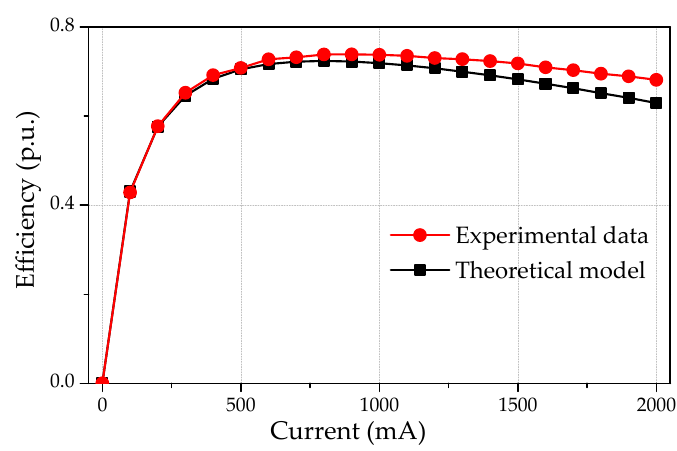
Figure 14. AFPM generator efficiency for n = 1500 rpm.